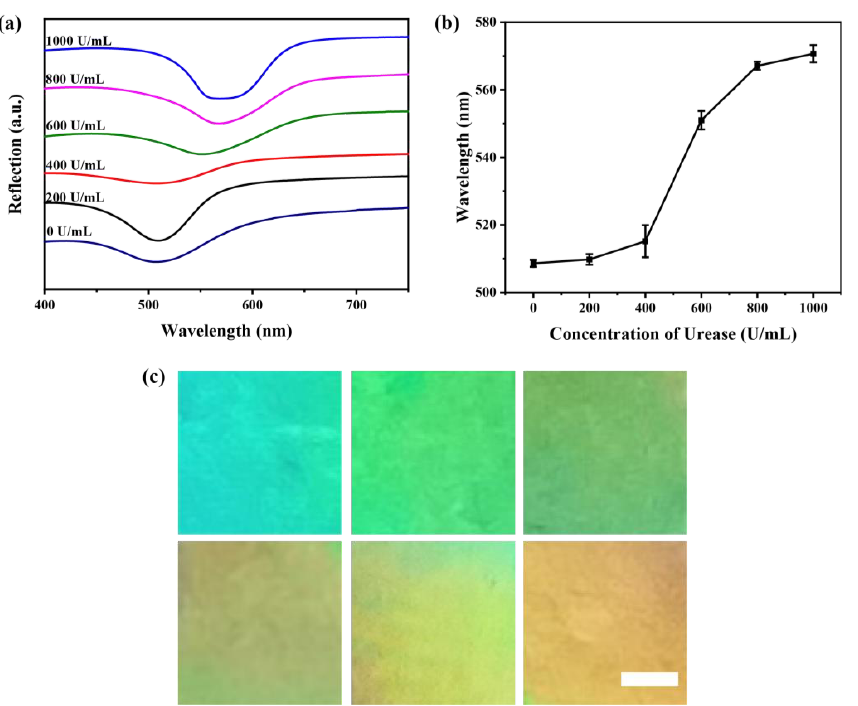
Figure 10. ( a ) The UV-visible reflection spectra of CLC-PAA PC films at different concentrations of urease (The films were treated with 10 mM urea for 10 min.); ( b ) The wavelength values of the reflection light; ( c ) The optical images of CLC-PAA PC films at different concentrations of urease. scale bar: 1 mm.